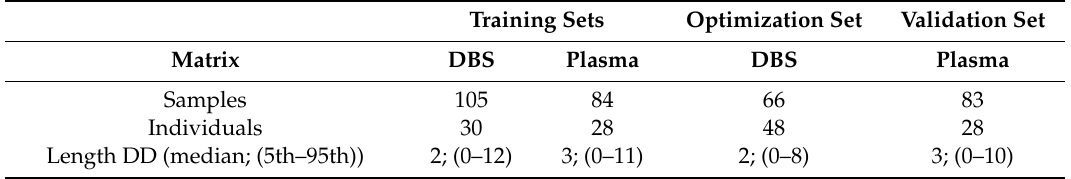
Table 2. Performance automated data interpretation for control sample